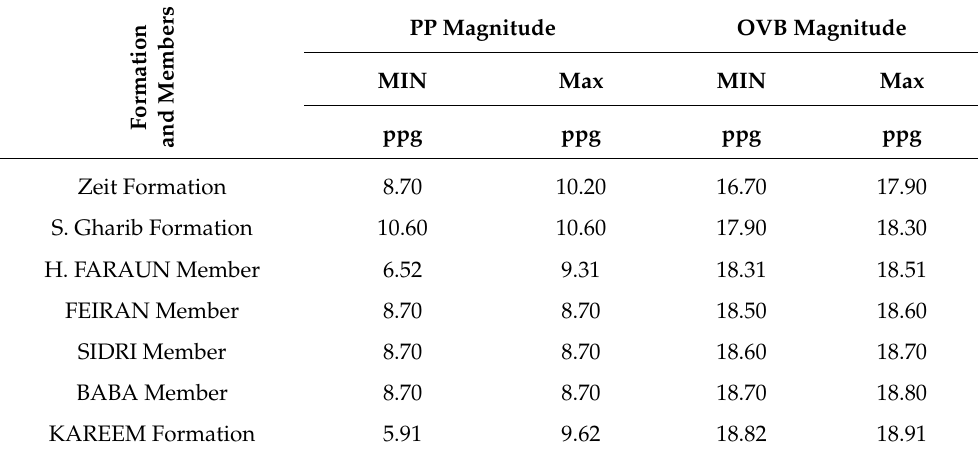
Table 2. The developed pore pressure and overburden magnitudes of El Morgan